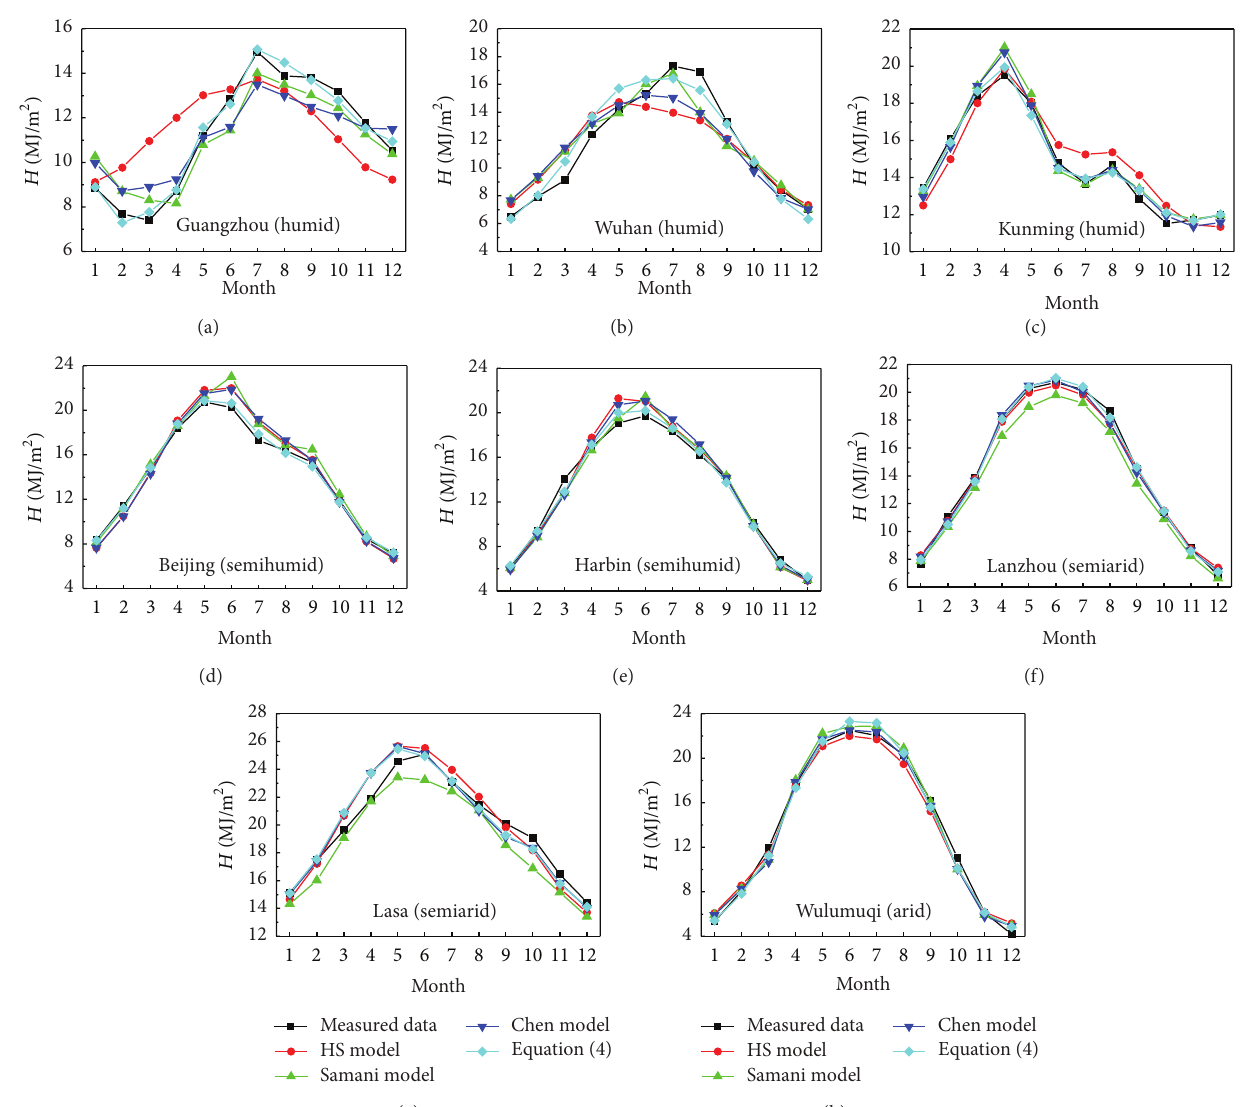
Figure 2: Comparison between the estimates of the four models and measured data at eight representative stations.